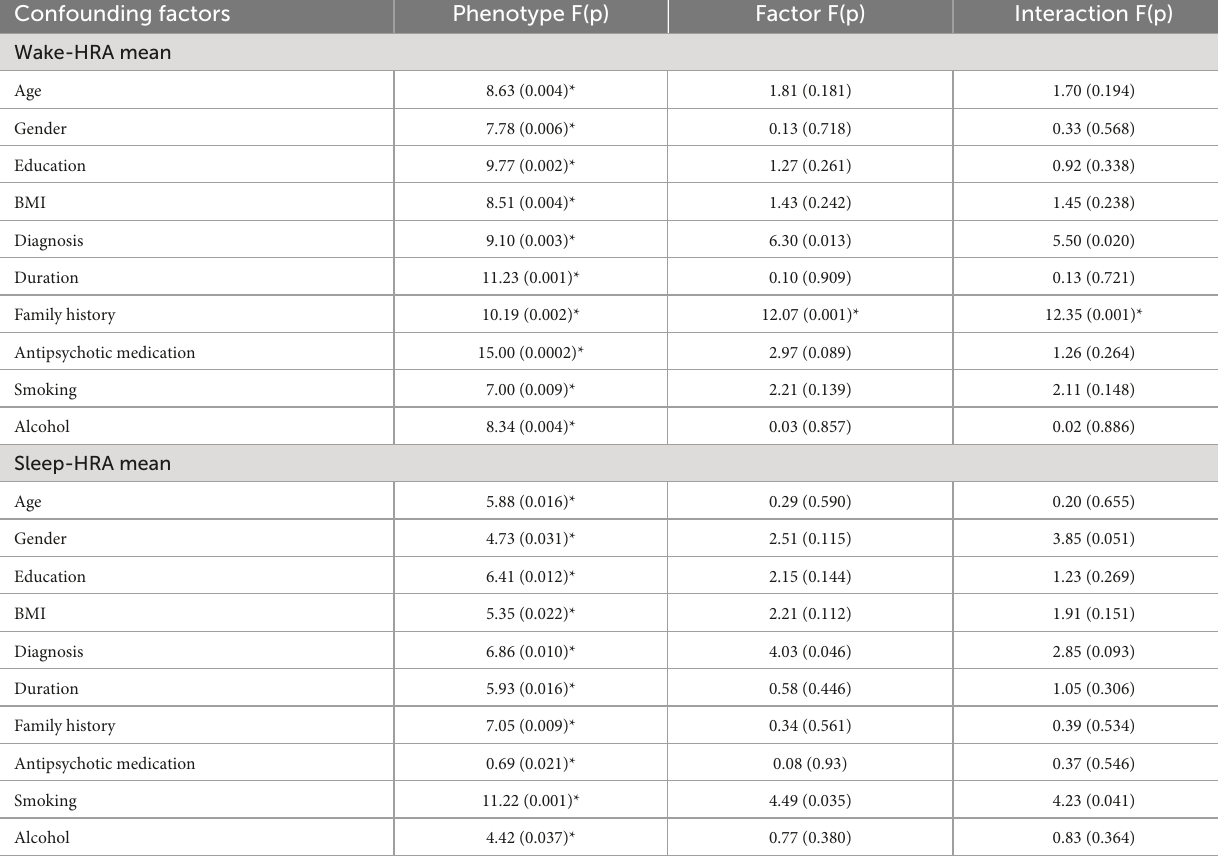
TABLE 4 Digital phenotype interactions with demographic, clinical and pharmacological factors in predicting positive